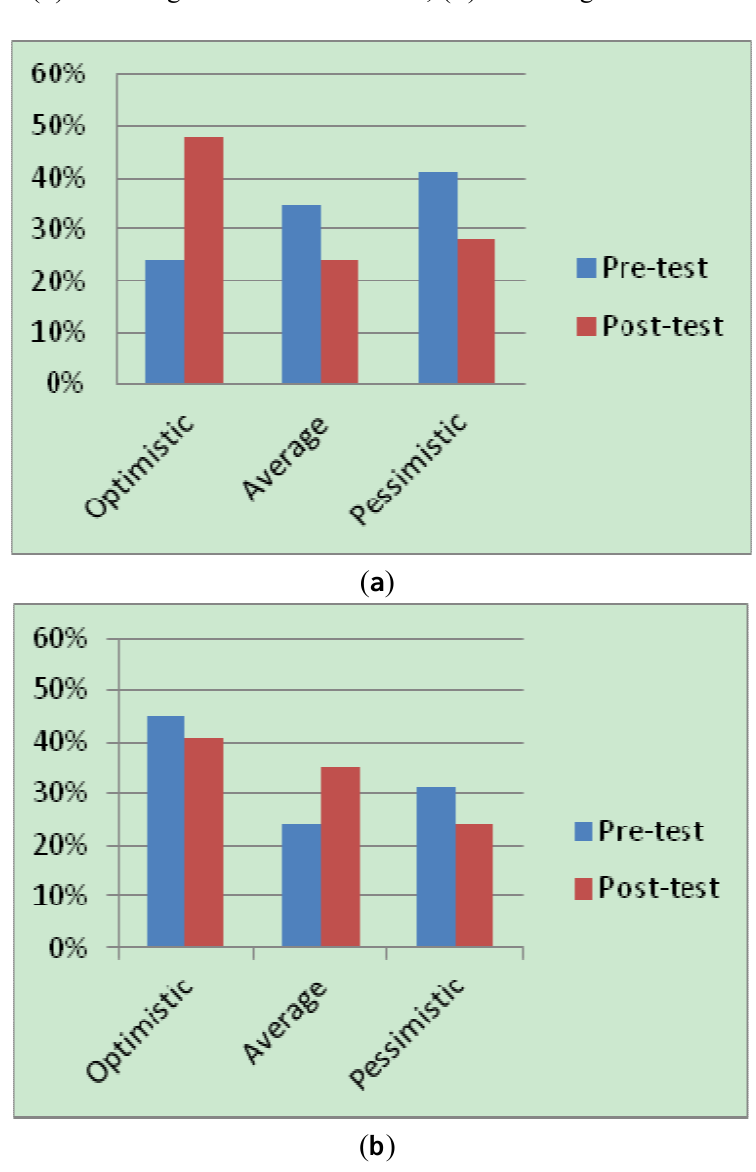
Figure 2. ( a ) Percentages based on TB scores ; ( b ) Percentages based on TG scores